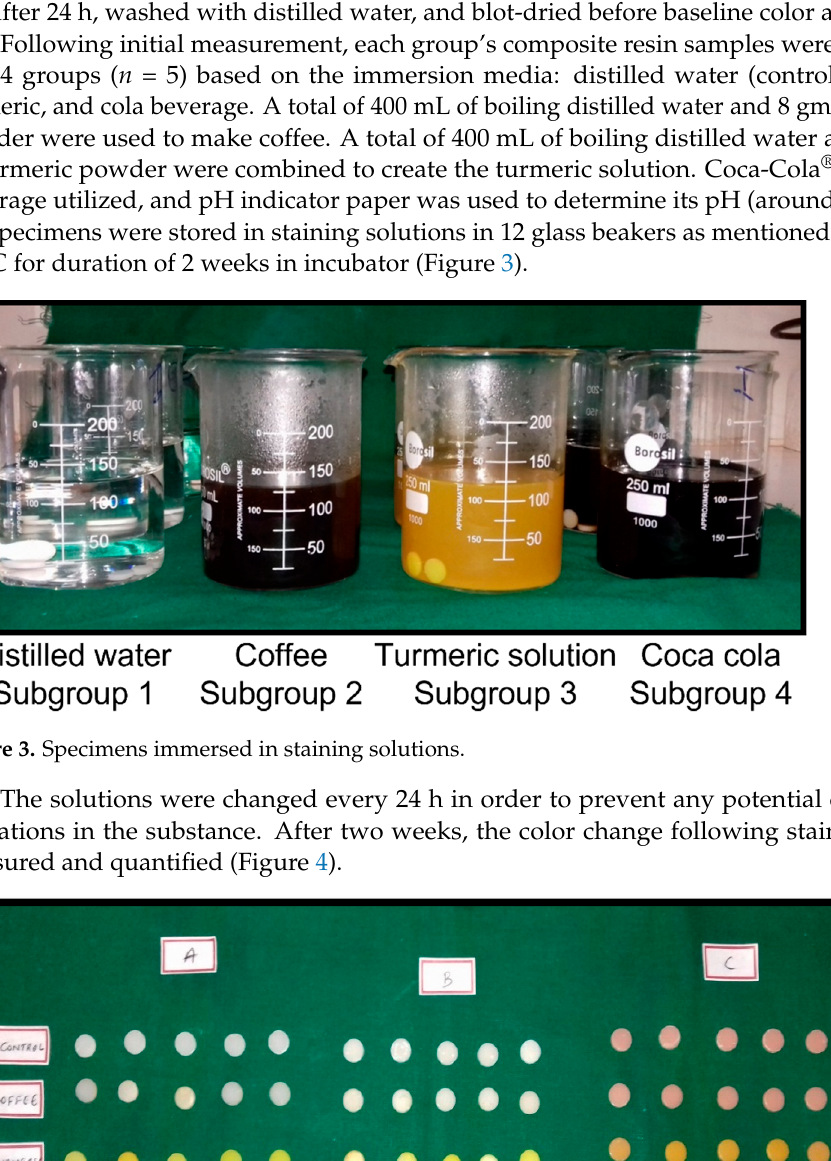
Figure 5. ( A ) Specimen cleaned using electric toothbrush and toothpaste. ( B ) Spectrophotometer used to measure the color change of specimen after 2 weeks of immersion in staining agents. A spectrophotometer (X-Rite i1 Eye-One Pro Rev D Spectrophotometer, Al- thardstrasse, Regensdorf, Switzerland) unit attached to a computer was used to measure the specimens’ color, and the programme Measure tool i1 pro Profilemaker version 5.0.10 was used to record the spectrophotometric data and total color difference E for each disc sample. On a white backdrop, colorimetric measurements of the samples were made us- ing the CIELab color space, capturing the L*, a*, and b* values. For each specimen, a mean value for the L*, a*, and b* values was calculated using three measurements. After two weeks of immersion in the three staining solutions and the water control, color measure- ments were carried out once again. All L*, a*, and b* value recordings were performed by a single examiner. Utilizing Hunter’s equation, Δ E = [( Δ L*) 2 + ( Δ a*) 2 + ( Δ b*) 2 ] 1/2 , values for E were determined (Figure 5B). A single value, ∆ E, was used to determine the overall color difference between the two places (baseline and after two weeks of storage in staining agents) in the three-